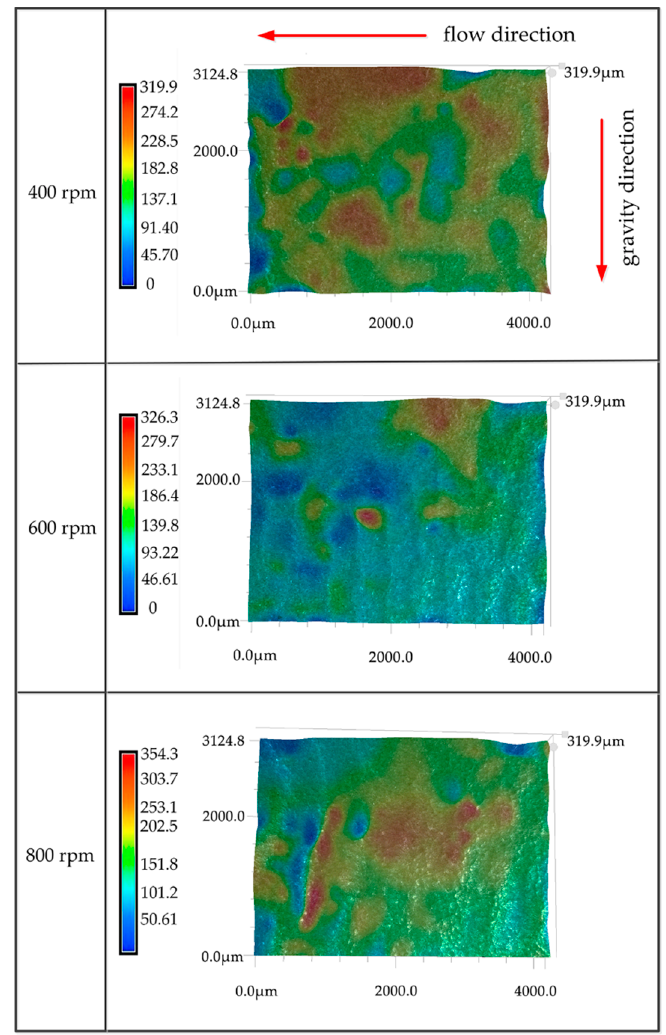
Figure 17. Gully heights of aluminum sheet surfaces at different rotation speeds and 10% mass concentration (unit: µm).